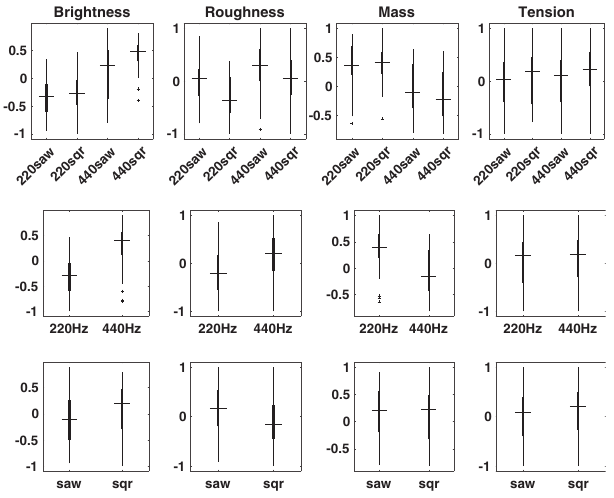
Figure 2. The top panels show the boxplots of the ratings on the four qualities for the four 3-s static stimuli. The medians were used as initial values for the average quality-pro fi les of the main experiment shown in Figure 4. The middle and the bottom panels show the boxplots as a function of F 0 and spectral shape to better illustrate the effects identi fi ed from the two-way repeated measures